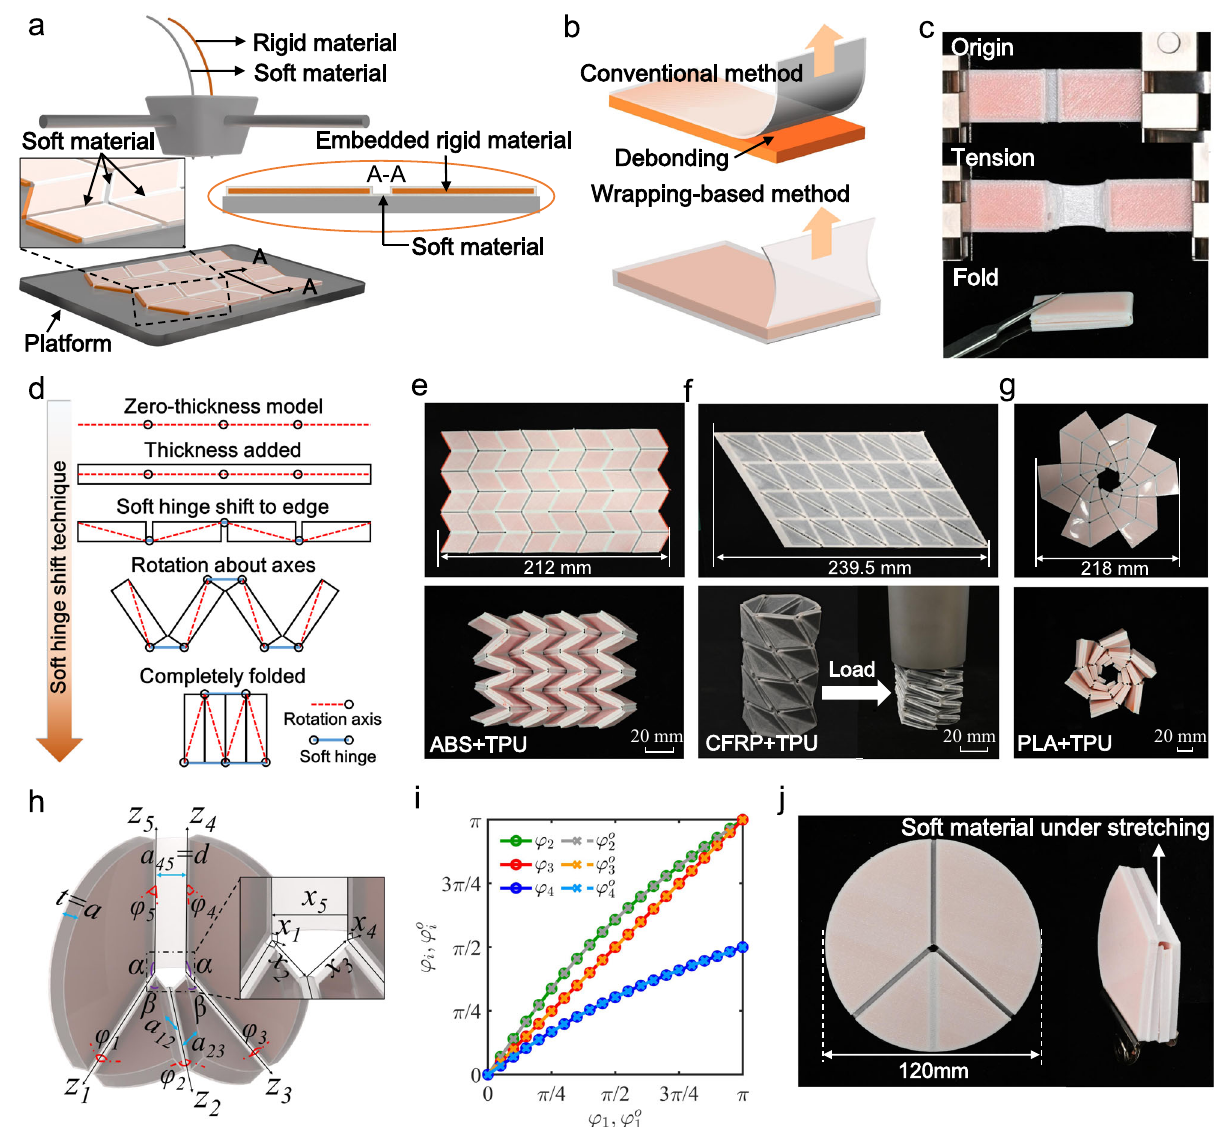
Fig.1|Fabricationanddesignofthick-panelorigami.a Illustrationofthick-panel origami fabrication through FDM multimaterial 3D printing. b Comparison on the interfacial property of multimaterial 3D printed samples by conventional and wrapping-based strategies. c Snapshots of wrapping-based hinge under tension andfold. d Conceptofsofthingeshifttechnique. e – g Demonstrationsof3Dprinted thick-panel origami with Miura, Kresling, fl asher pattern, whose rigid component